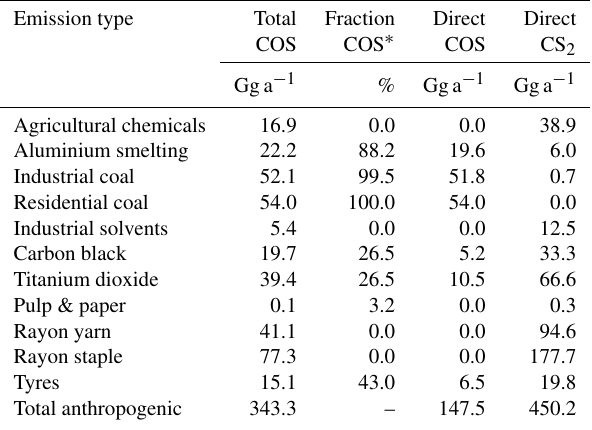
Table 1. The split of anthropogenic emissions in the different cate- gories and between COS and CS 2 based on Zumkehr et al. (2018). Note that we used a CS 2 -to-COS molar yield of 0.87 and that CS 2 contains two S atoms. Averages over 2000–2012 are